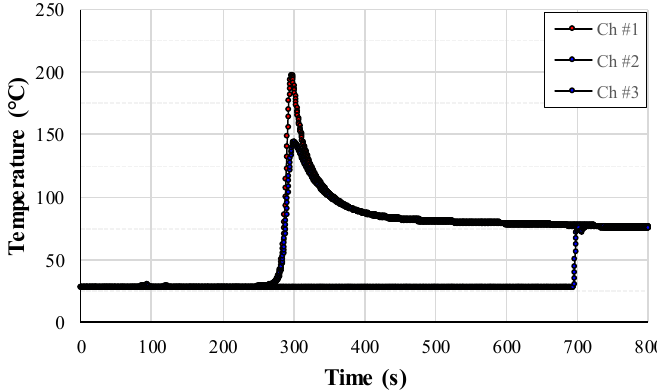
Figure 12. A Temperature history during GMAW (Al 6061 T6).